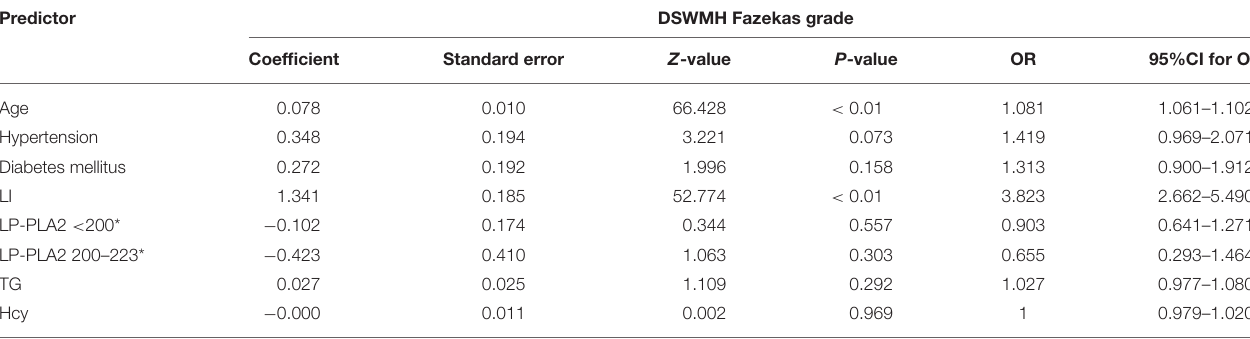
TABLE 5 | Ordinal regression model analysis of influencing factors of DSWMH classifications.